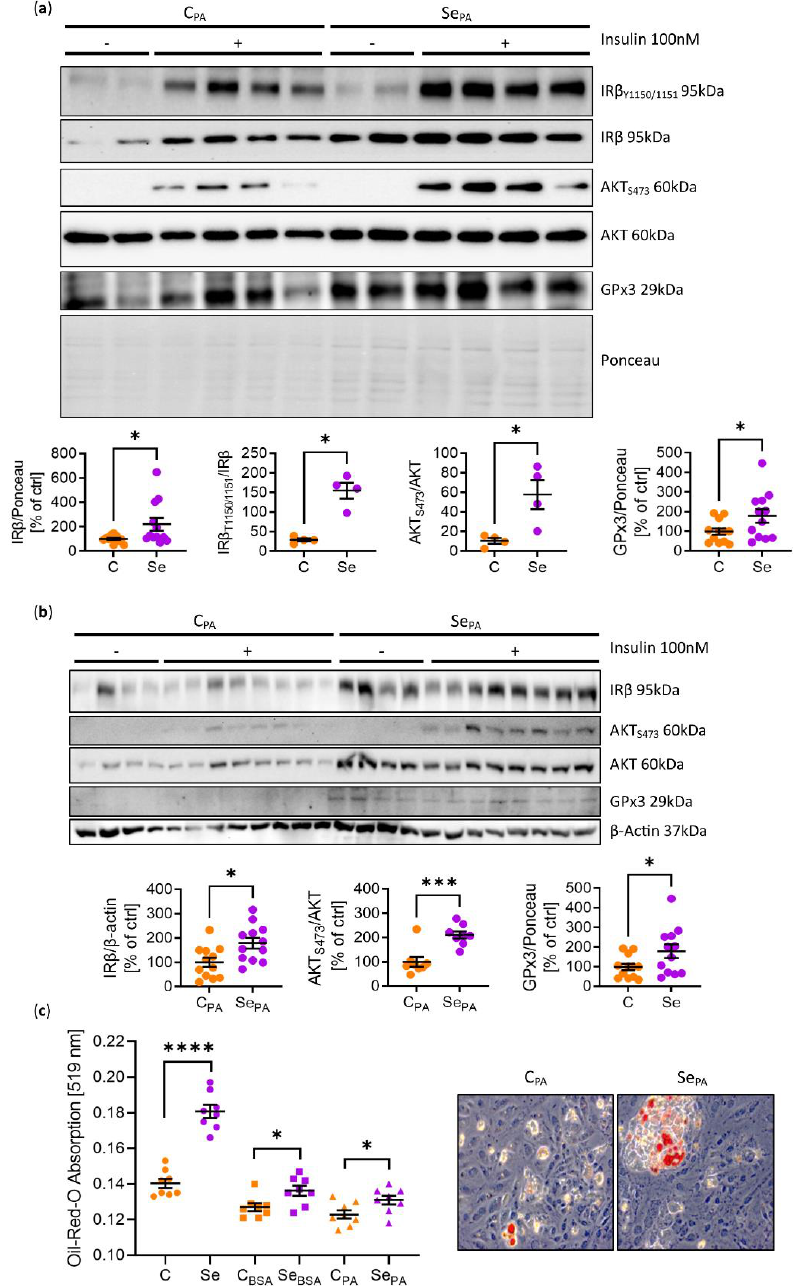
Figure 2. Selenite treatment improves insulin sensitivity under lipotoxic conditions. ( a ) Representative protein phosphorylation, expression, and densitometric analysis of members of the insulin signaling cascade in mature 3T3-L1 adipocytes treated with or without selenite during differentia- tion and after 100 nM insulin stimulation. ( b ) Representative protein phosphorylation, expression, and densitometric analysis of members of the insulin signaling cascade in 3T3-L1 preadipocytes pre-treated with or without palmitate for three days, with or without selenite for further three days, and after 100 nM insulin stimulation. ( c ) Oil-Red-O absorption and representative staining of 3T3-L1 adipocytes differentiated in the absence or presence of selenite and palmitate for 8 days. *: p < 0.05, ***: p < 0.001, ****: p < 0.0001 after two-tailed Student’s t -test. All data are presented as mean ±